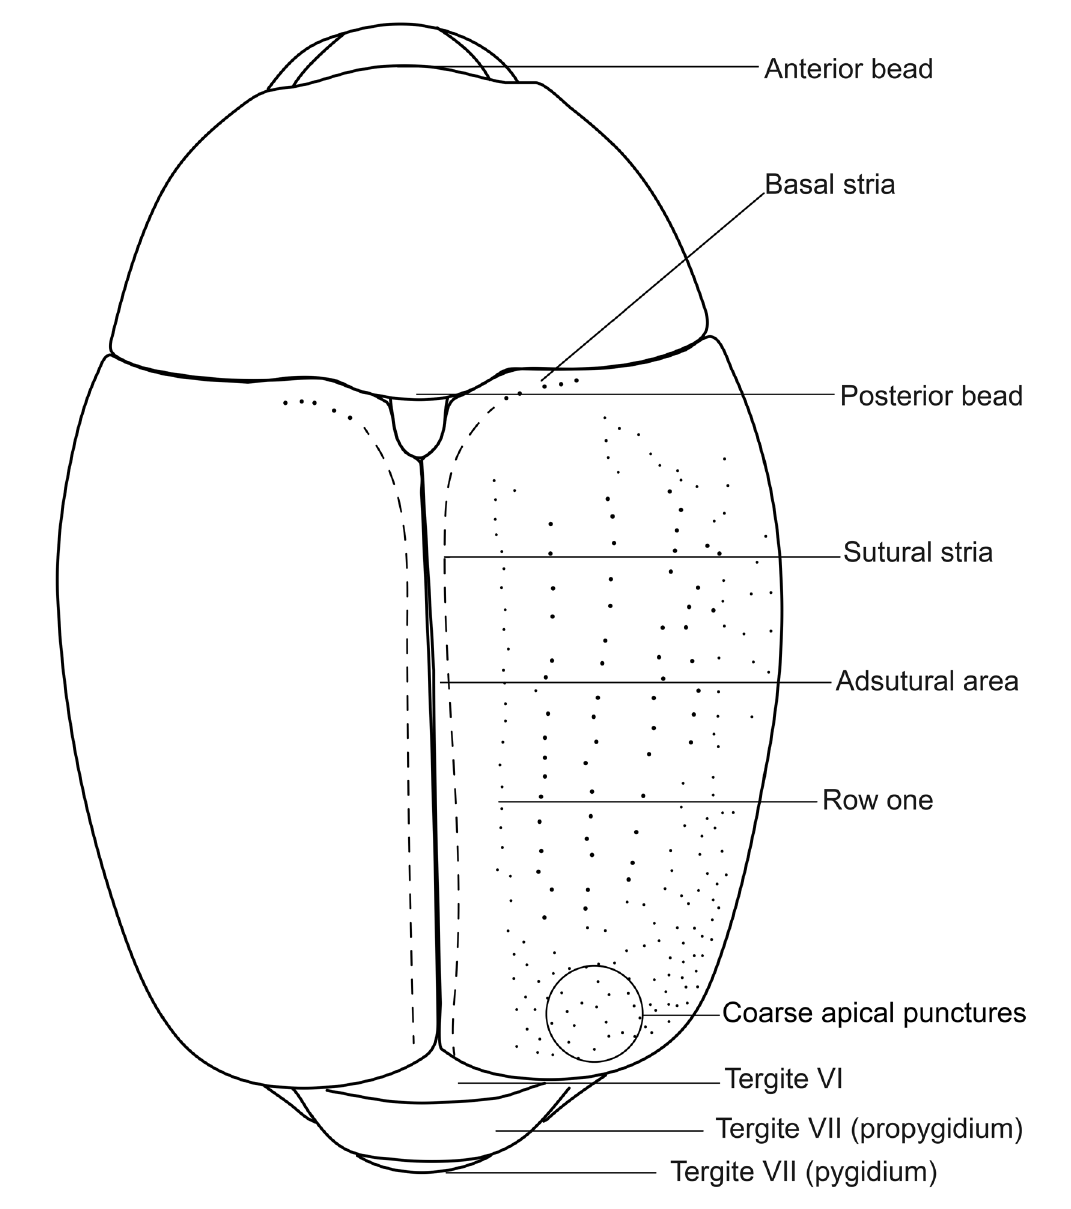
Fig. 2. Dorsal terminology. Model: Cyparium collare Pic,